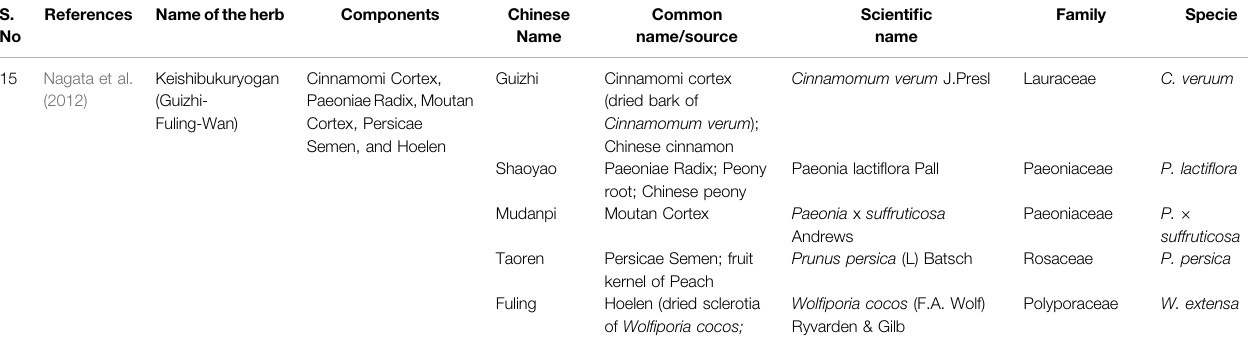
TABLE 2 | ( Continued ) Taxonomic classi fi cation of all the polyherbal combinations used in clinical studies against metabolic